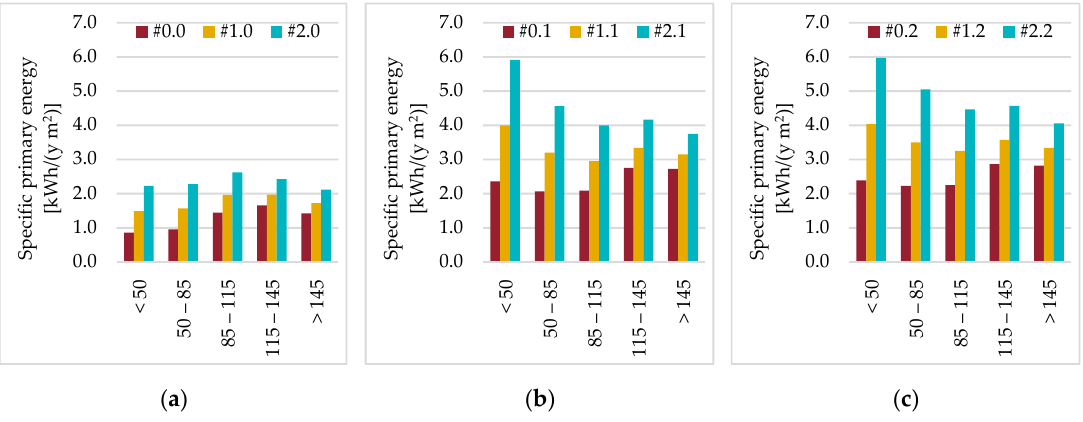
Figure 14. Milan: Specific primary energy consumption for cooling. ( a ) Existing equipment; ( b ) existing equipment + 1 air conditioner; ( c ) existing equipment + 2 air conditioners.